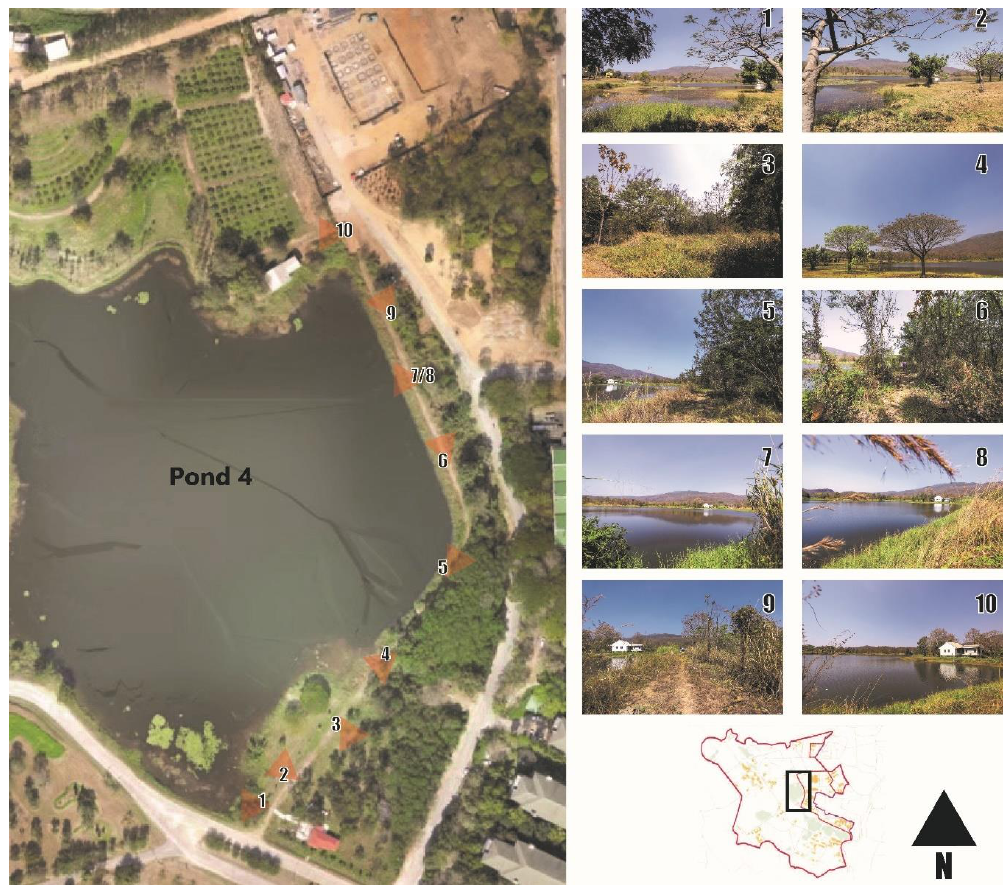
Figure 2. Example of site investigation report, showing beautiful sceneries next to Pond 4, but at the same time showing some overgrown vegetation and swales. same time showing some overgrown vegetation and